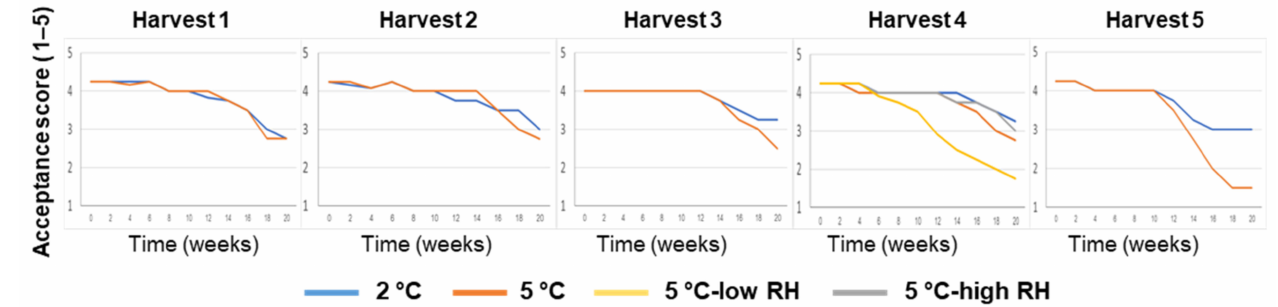
Figure 4. Effects of various preharvest and postharvest features on the acceptance scores of ‘Valencia’ oranges harvested from five different orchards. The harvest times and yields of the different orchards are presented in Table 1. The postharvest features included the storage temperature (2 ◦ C or 5 ◦ C) and storage RH (70%, 90%, or 95%). Fruit quality was evaluated every 2 weeks after 1 additional week of storage under shelf conditions (at 20 ◦ C) for a period of 20 weeks.